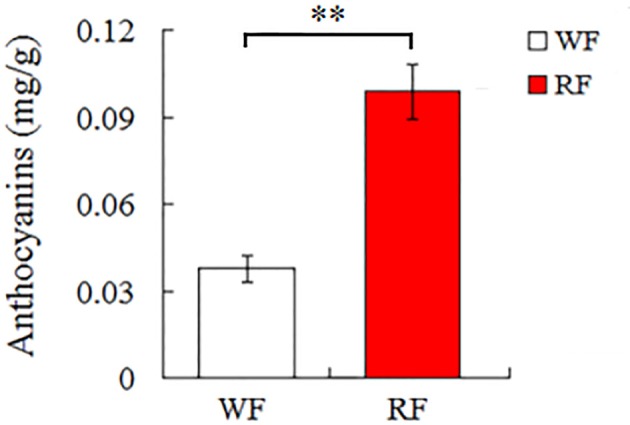
Anthocyanin content of white (WF) and red (RF) flowers samples in Japanese apricot. Asterisk indicates significant differences (**p < 0.05).